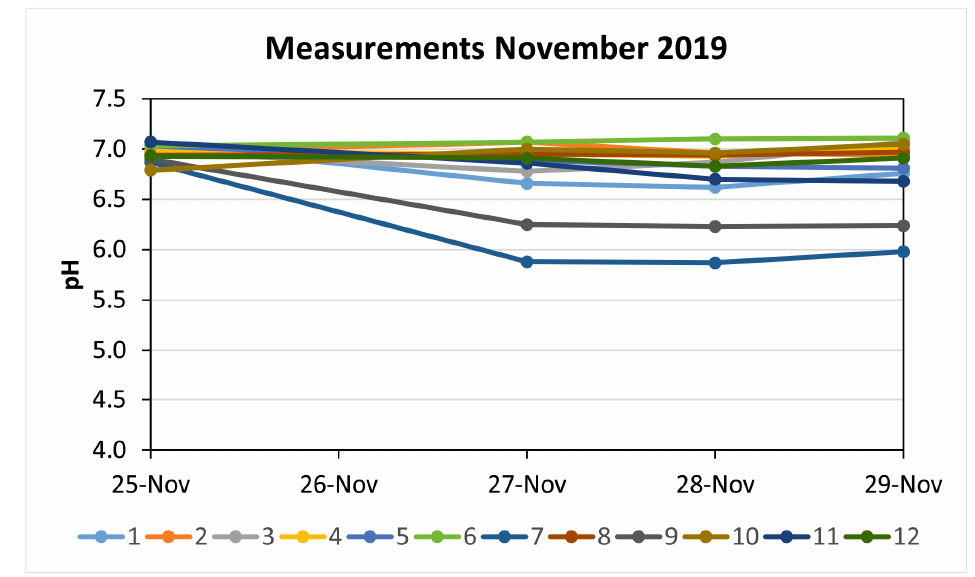
Figure 7. pH average results obtained during the evaluation carried out on November 2019. Numbers at the bottom of the X axis are the sensor numbers.